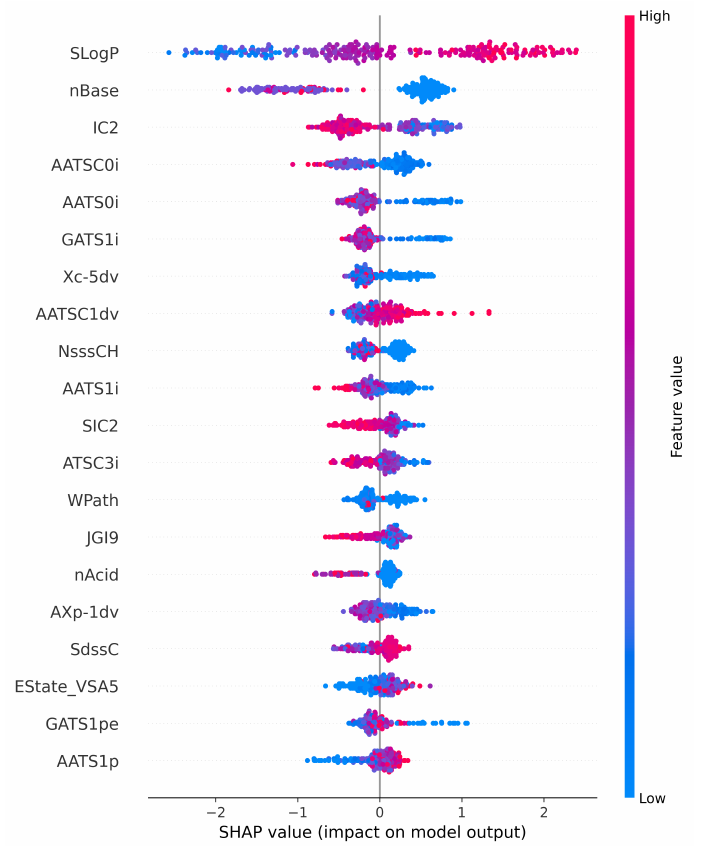
Figure 6. SHAP summary plot shows the contribution of the top 20 descriptors of the CatBoost model for mitochondrial toxicity